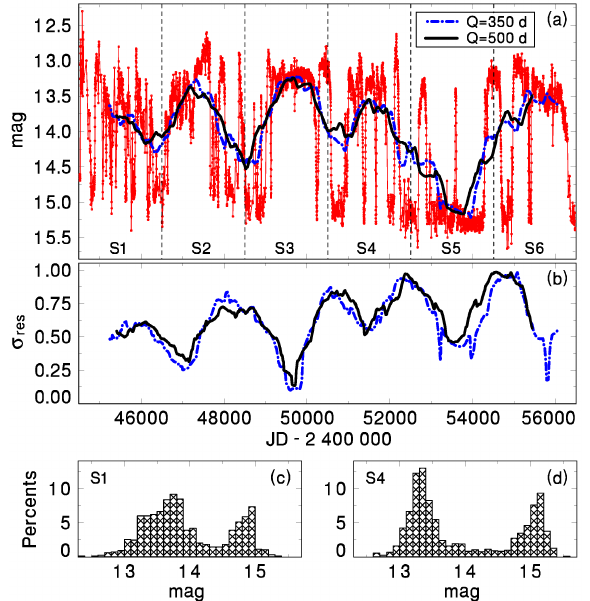
Figure 1: (a) The long-term activity of AM Her in the optical band (AAVSO data [6]). HEC13 fit runs through the orbital modulation. The mapping is di- vided into segments. The smooth lines represent the moving averages (MA). (b) Residuals of the MA. (c, d) Examples of the strikingly different statistical dis- tributions of brightness. See Sect. 2 for details.